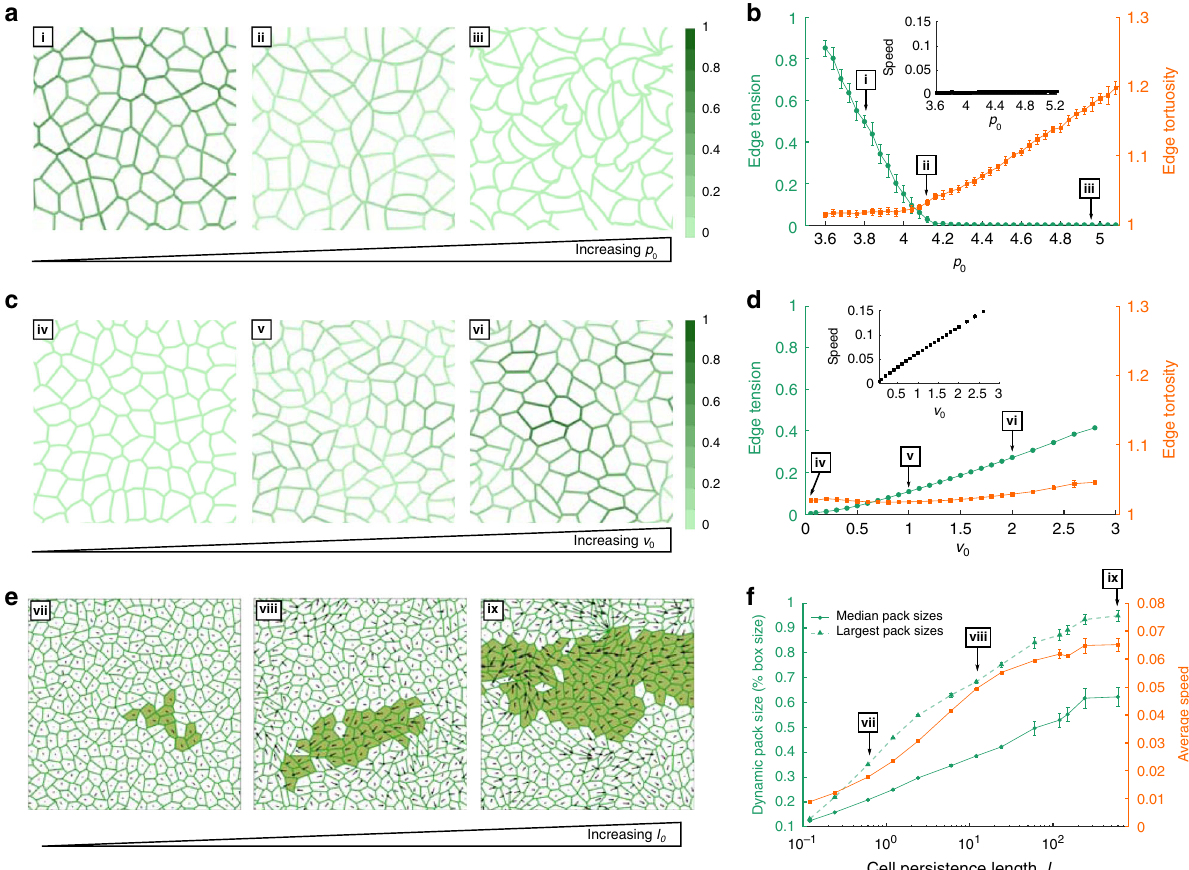
Fig. 4 Changes in tension, propulsion. and persistence in the dynamic vertex model (DVM) leads to different modes of fl uidization in a con fl uent cell layer. a When p 0 is small and propulsive forces ( v 0 ) are suf fi ciently small, the cell layer is jammed (i). Cells on average assume compact polygonal shapes 37,109 , and cell – cell junctions are straight. As p 0 progressively increases cell shapes become elongated (ii) and cell edges become increasingly tortuous, as if slackened (iii). Further, as p 0 increases, tension in the cell edges decreases (depicted by color intensities). b Increasing p 0 decreased mean edge tension (green), with a transition near p 0 = 4.1, at which point edge tensions dropped to near zero and edge tortuosity began to rise (orange). This loss of edge tension coincides with a solid – fl uid transition of the layer, at which point the shear modulus 114 and energy barriers vanish (Supplementary Fig. 4a). c If p 0 is moderate ( p 0 = 4) and propulsive force v 0 is small the cell layer is immobile (iv). As v 0 is progressively increased, however, cell shapes elongate but cell – cell junctions remain straight (v, vi). Further, as v 0 increases, edge tensions increase. d Increasing v 0 increases edge tension (green) but without an increase in edge tortuosity (orange). Simultaneously, the speed of the cell migration increases (inset). This increase in cell speed coincides with fl uidization of the layer: v fi cient to overcome energy barriers that impede cellular rearrangements. Data presented in b and d are mean ± SD 0 becomes suf for n = 7 – 20 independent simulations for each datapoint. e Increasing the single cell persistence length l 0 (in units of the average cell diameter, see Supplementary Methods) at constant p 0 = 4 and v 0 = 1.2 leads to the emergence of growing migrating packs (vii – ix) 92,126 . Single cell velocity is represented as a vector; the largest pack is highlighted. f The median size of migrating packs (green circles) and corresponding average cell speeds (orange squares) increase in tandem as l 0 increases. Data presented in f are mean ± SD for n = 8 – 9 independent simulations for each datapoint. The linear sizes of the packs are measured relative to the size of the simulation window (Supplementary Methods). The largest migrating packs are also shown (green triangles), which grow to the size of the simulation window for l 0 > 100, highlighting the scalability and robustness of pack formation in